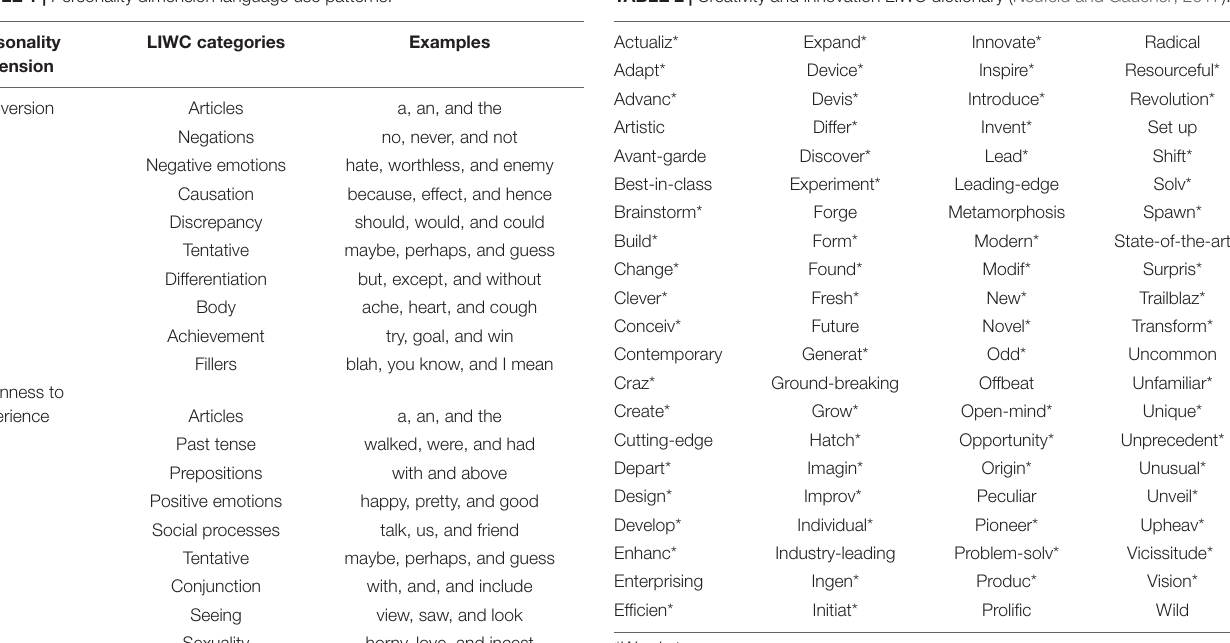
TABLE 1 | Personality dimension language use patterns. TABLE 2 | Creativity and innovation LIWC dictionary (Neufeld and Gaucher,